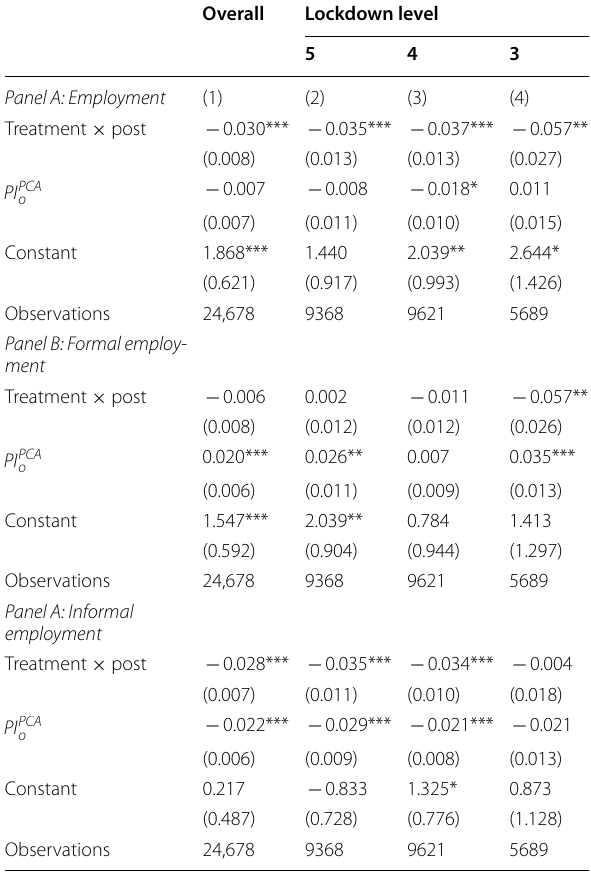
Table 11 Model estimates, controlling for